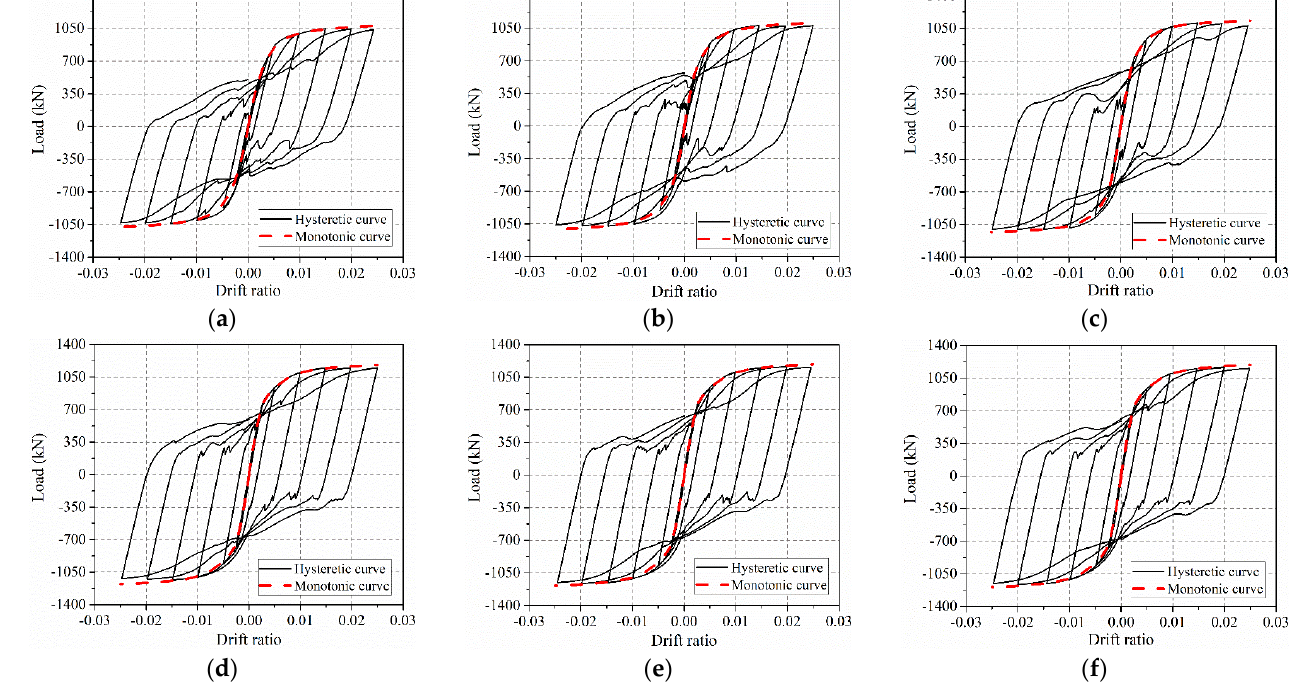
Figure 8. Hysteretic curves for SPSW1 − 1VHS with different η : ( a ) η = 0 (USPSW1); ( b ) η = 10; ( c ) η = 30; ( d ) η = 60; ( e ) η =90; ( f ) η = 120.